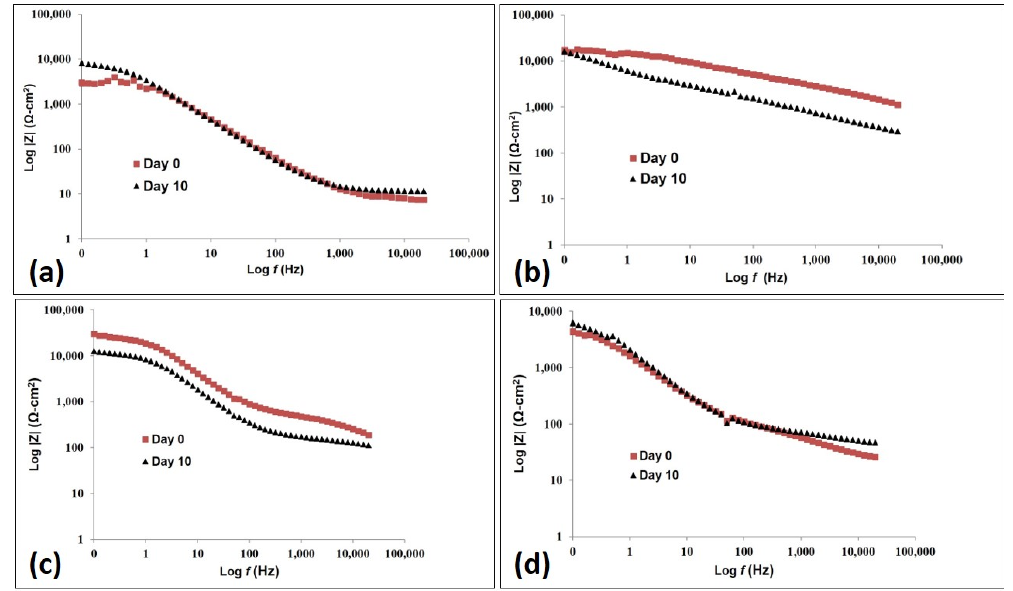
Figure 14. Bode plots for ( a ) Al substrate, ( b ) HA, ( c ) PEO and ( d ) PSC coatings at different immersion